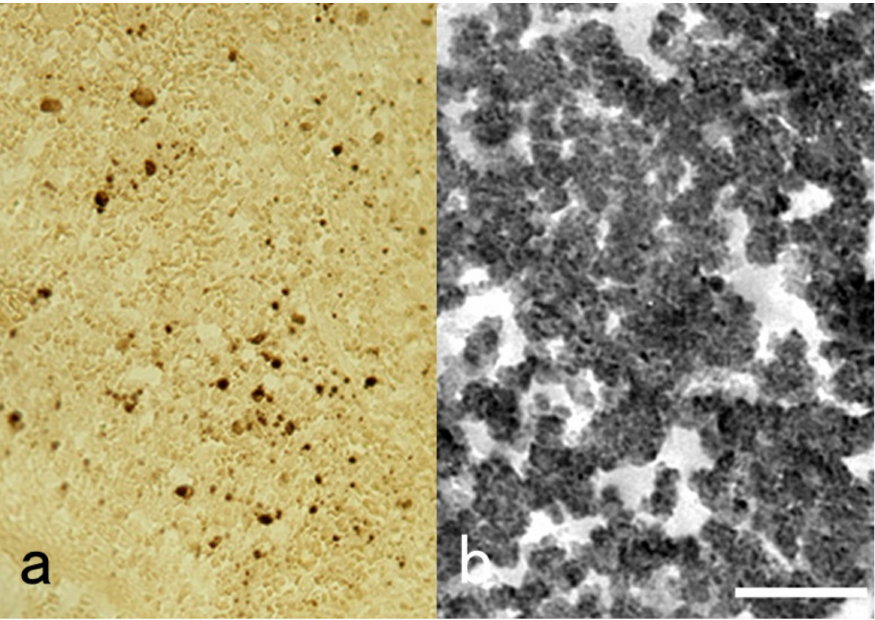
Figure 59. Pre-embedding immunoelectron microscopy for SFTS virus using a TACAS glass slide. ( a ): Light microscopic chromogenic immunostaining and ( b ): immunoreactive round-shaped viral particles, around 100 nm in size, at the ultrastructural level. The FFPE splenic red pulp from an autopsy case was immunostained with a monoclonal antibody to SFTS virus after HIER. For pre- embedding immunoelectron microscopy, the immunostained section was peeled off for transfer to an Epon-embedded block by the inverted beam capsule method. The miraculous TACAS glass slide pre- vents detachment of sections during immunostaining and allows cell transfer after